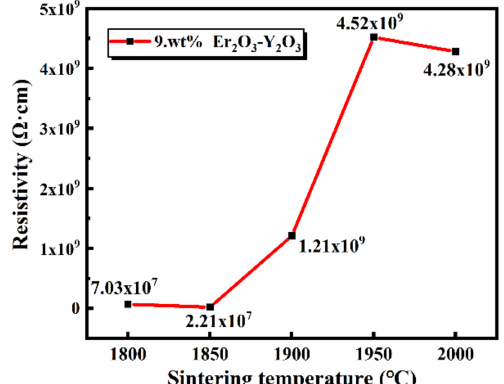
Figure 6. The dc electrical resistivity of the sintered SiC samples with 9 wt.% Y 2 O 3 -Er 2 O 3 as a function of the sintering temperatures.